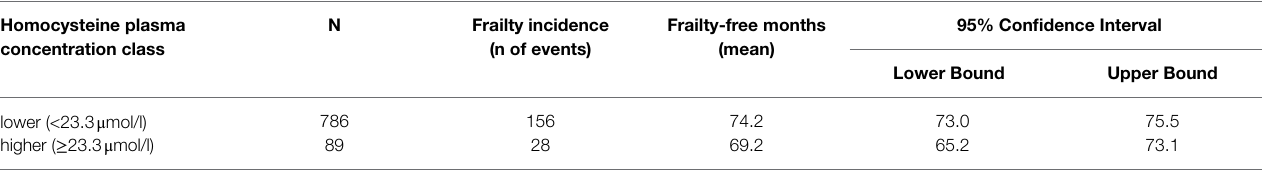
TABLE 7 | Frailty-free survival time for the two HOcy90 plasma concentration classes. Homocysteine plasma concentration class